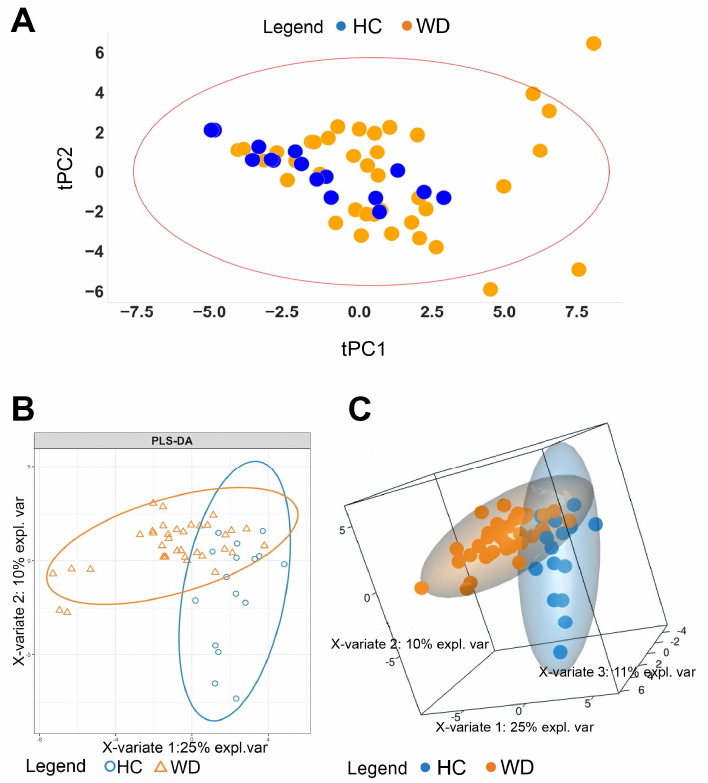
Table 2. Variable importance in projection (VIP) scores are shown for 7 metabolites. A cutoff value of 1.5 is established for VIP selection.